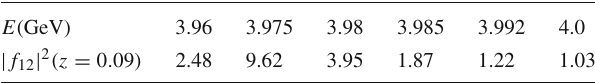
Table 4 The values of the transition probability as a function of energy in the transition 4)